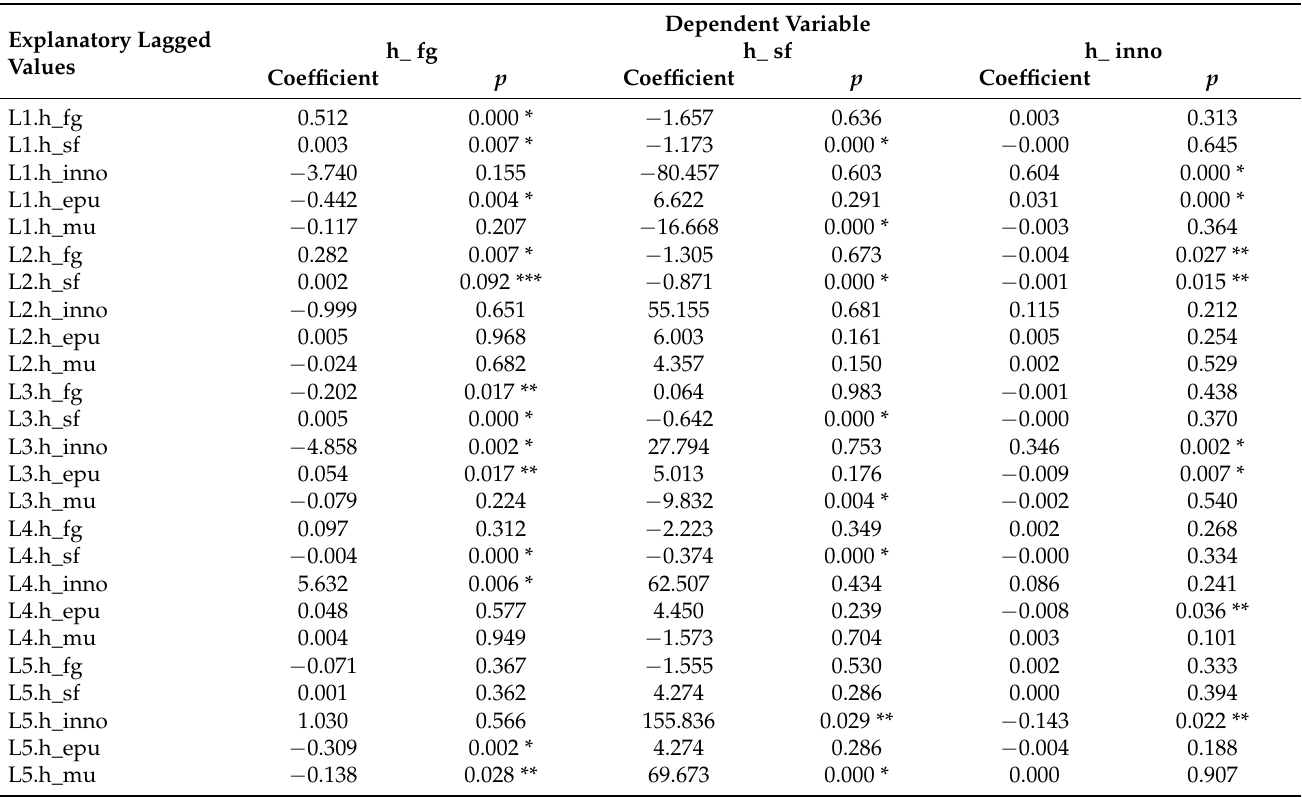
Table 5. Panel VAR